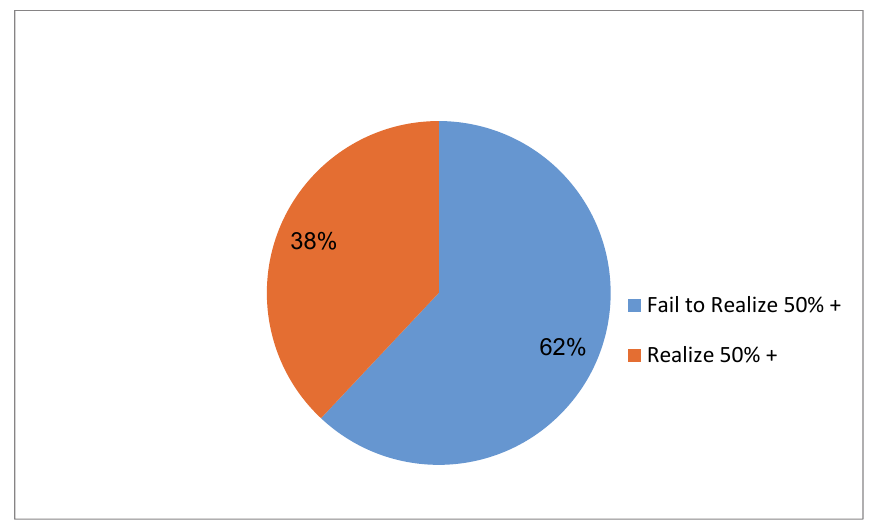
Fig. 6. Trends in realizing huge business